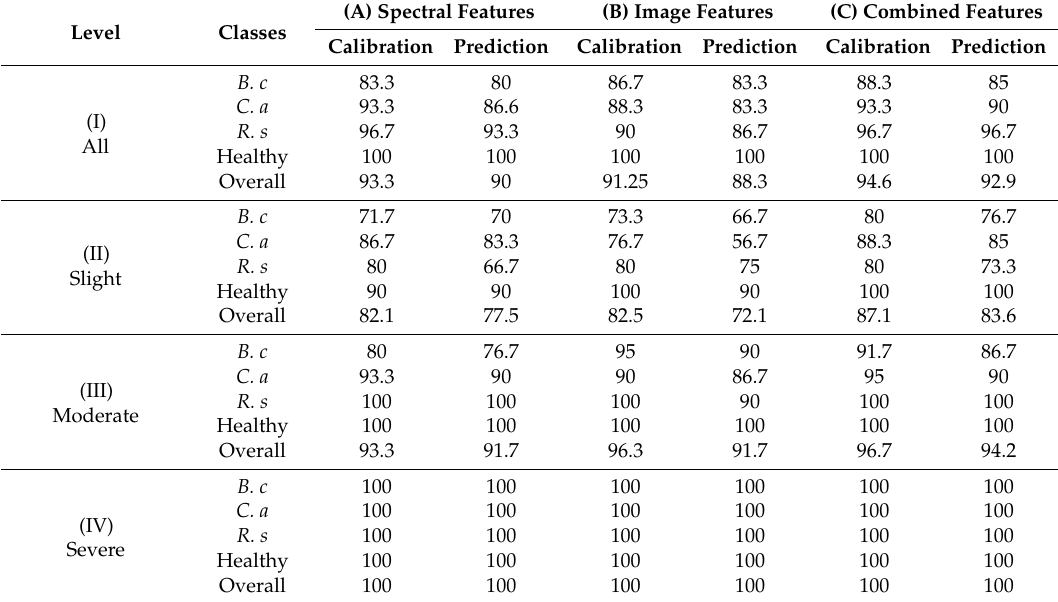
Table 3. The results of the classification of three fungal diseases in peaches for three levels of decay, using the spectral and image features of PLS-DA